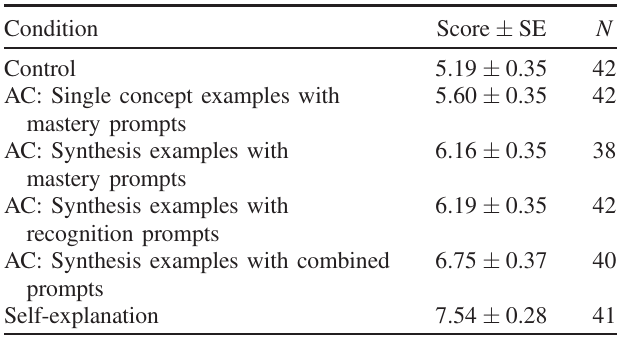
TABLE V. Mean score on target synthesis problem out of a maximum score of 10 points by condition. Errors shown are standard errors. Analogical comparison conditions are labeled